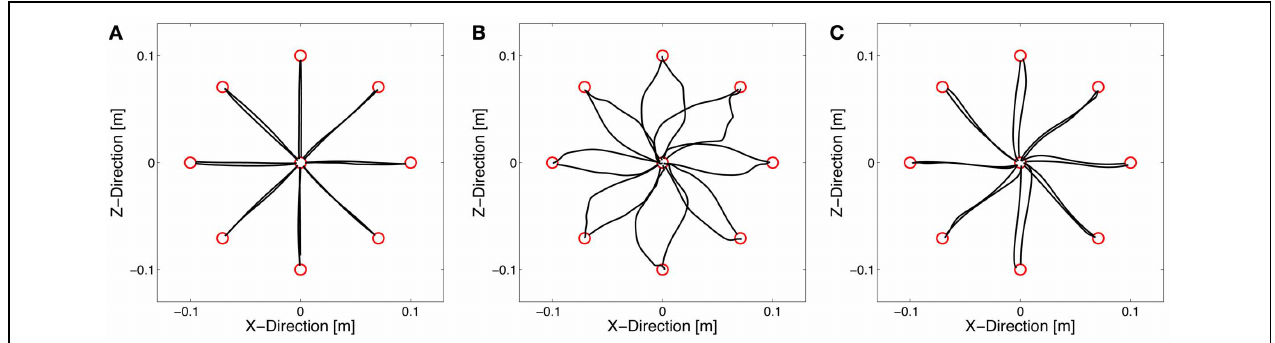
FIGURE 3 | Hand trajectories of one subject (group T1) under null field condition (A), at the beginning of learning force field A (B), and at the end of learning force field A (C). The subject showed